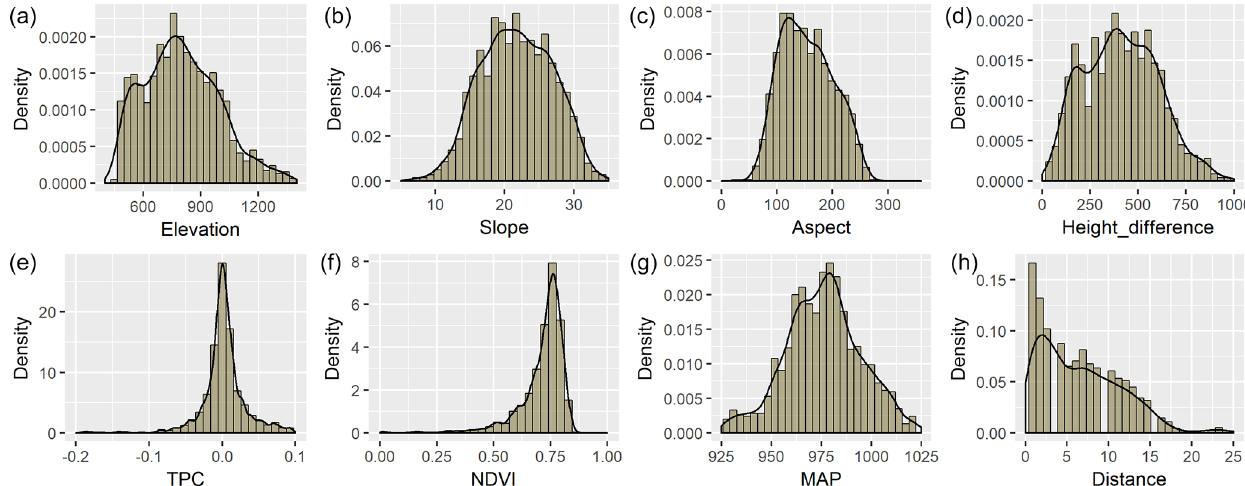
Figure 4. The frequency distribution of each indicator in the landslide location. Maps (a) , (b) , (c) , (d) , (e) , (f) , (g) and (h) represent the elevation, slope, aspect, height difference, TPC, NDVI, MAP and distance from the fault,